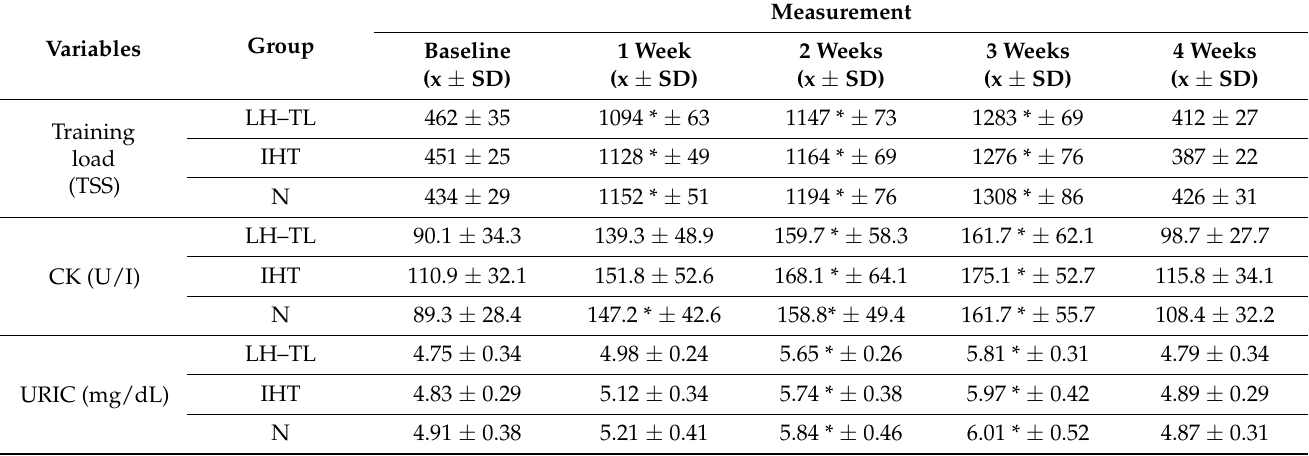
Table 3. Training load and changes in selected biochemical indices in the study groups (LH–TL, IHT, and N) during the first experiment; * p < 0.05—statistically significant differences compared to